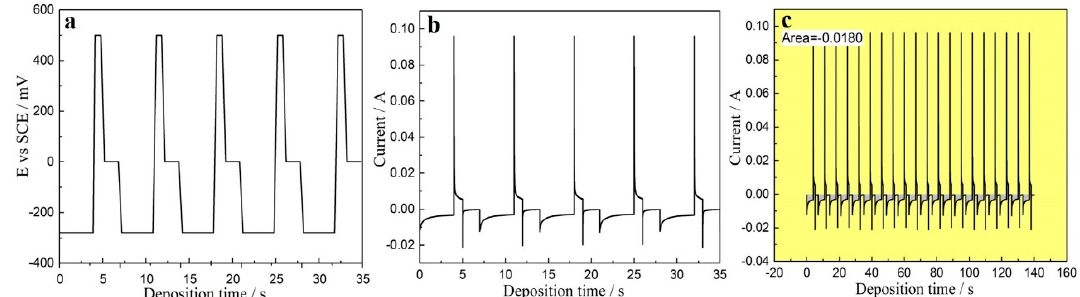
Figure 7. ( a ) Three-step pulsed voltage-time curve, ( b ) current-time curve, and ( c ) integral charge of deposits under pulsed voltage conditions.